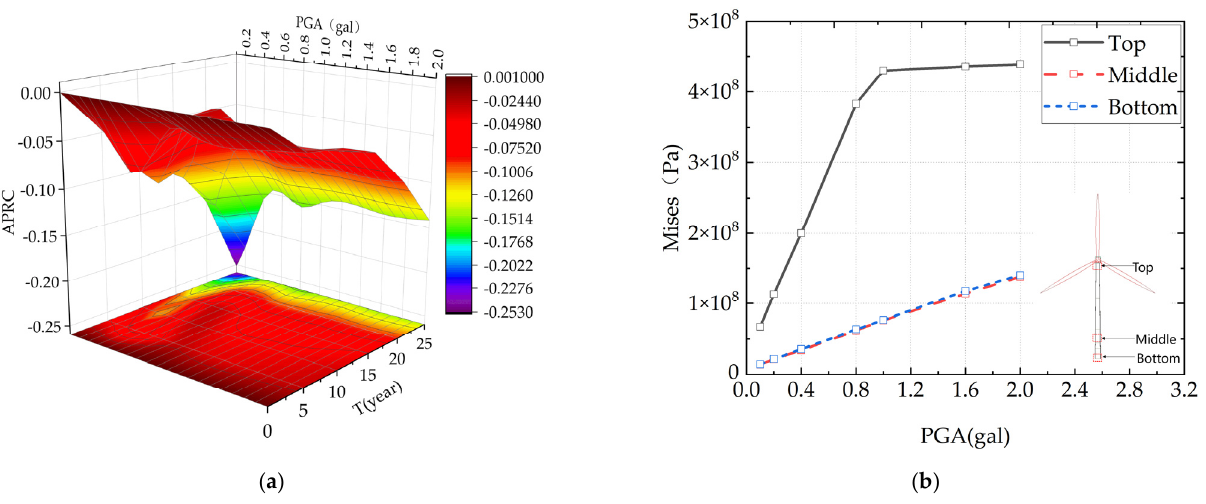
Figure 15. The Hyogoken-Nanbu earthquake: ( a ) structural APRC value; ( b ) maximum Mises stress.